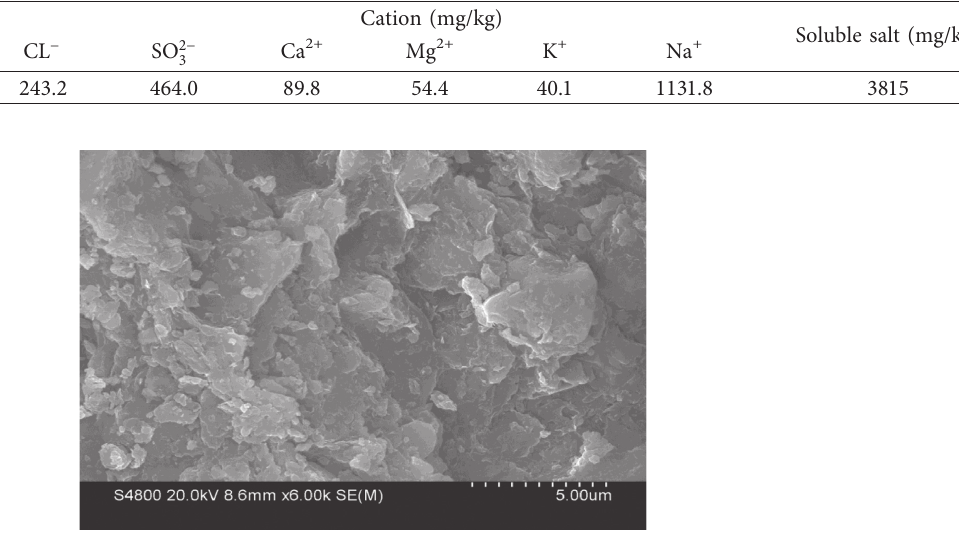
Figure 9: SEM micrographs of dispersive soil sample (magnitude �